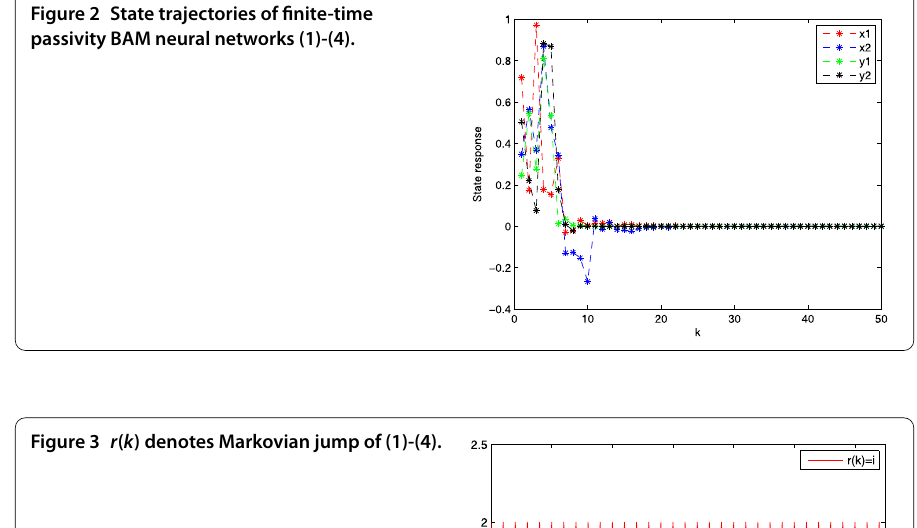
Figure 2 State trajectories of finite-time passivity BAM neural networks (1)-(4).